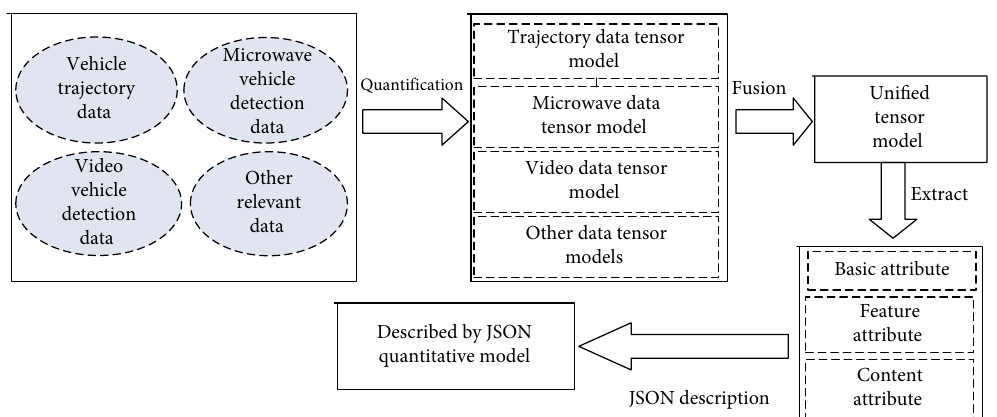
Figure 4: Traffic big data tensor model described by